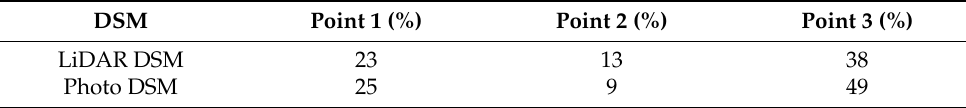
Table 1. RMSD values at the different measuring points in